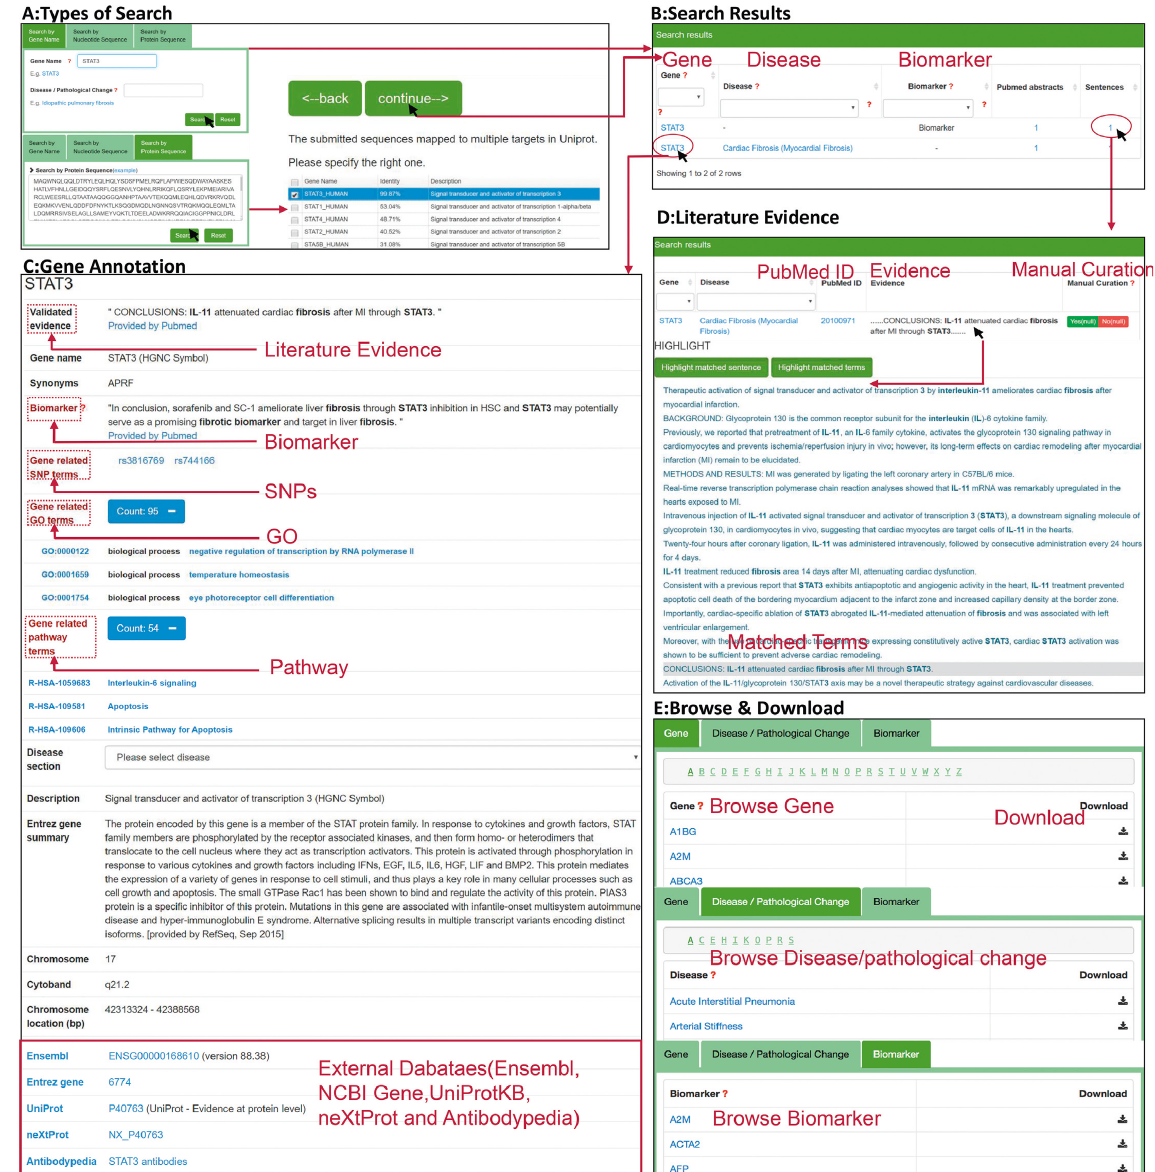
Figure 1: (A) Three main types of queries are supported by the “Home” page: gene symbol query, nucleotide sequence query, and protein sequence query. Users can input the gene symbol such as “STAT3” in the query box. Users can also input a nucleotide or protein sequence, and the sequence similarity identity score from BLASTwill be displayed. Choose the matched gene name and click “continue” to scan the set of search results. (B) In the result page, a table including the queried gene, related disease terminology, and supporting evidences is listed. (C) By clicking the gene symbol of “STAT3” in the “search results” interface, users can browse detailed information of “STAT3” and cross links to external databases. (D) By clicking the number of PubMed abstracts or sentences in the “search results” interface, users can scan a table containing the information of gene, associated disease terminology, PubMed ID, evidence, and manual curation. Click the link of evidence in this page to scan the abstract with highlighted keywords. (E) Three approaches for browsing are presented in the “Browse & Download” page. All the data can be